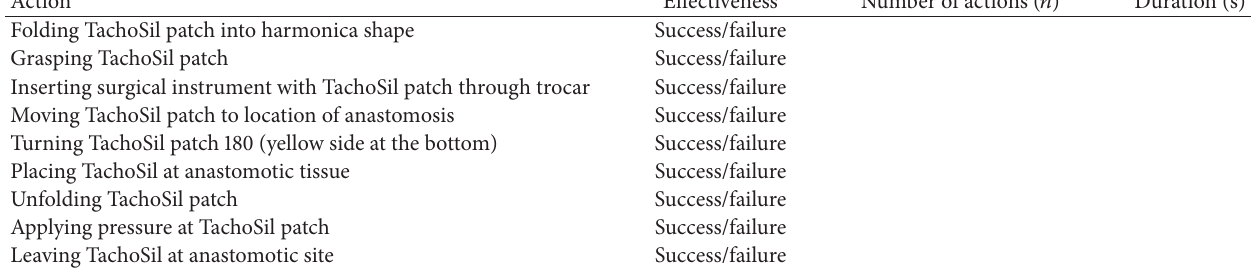
Table 3: Time-action score form for the harmonica technique of TachoSil application on esophagojejunostomy after laparoscopic total gastrectomy.